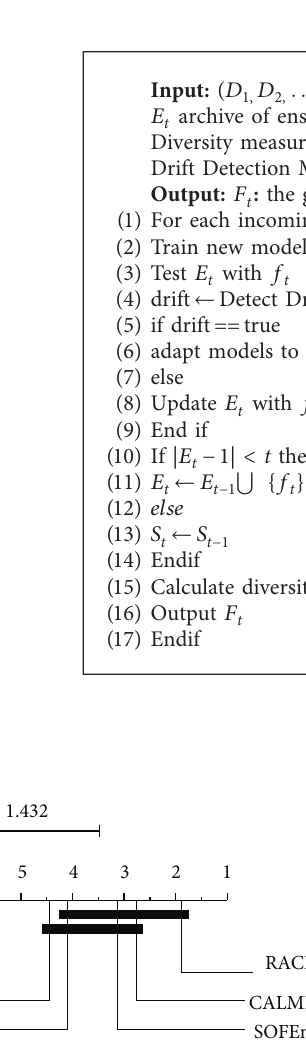
Figure 1: Average rank diagram of the five algorithms.